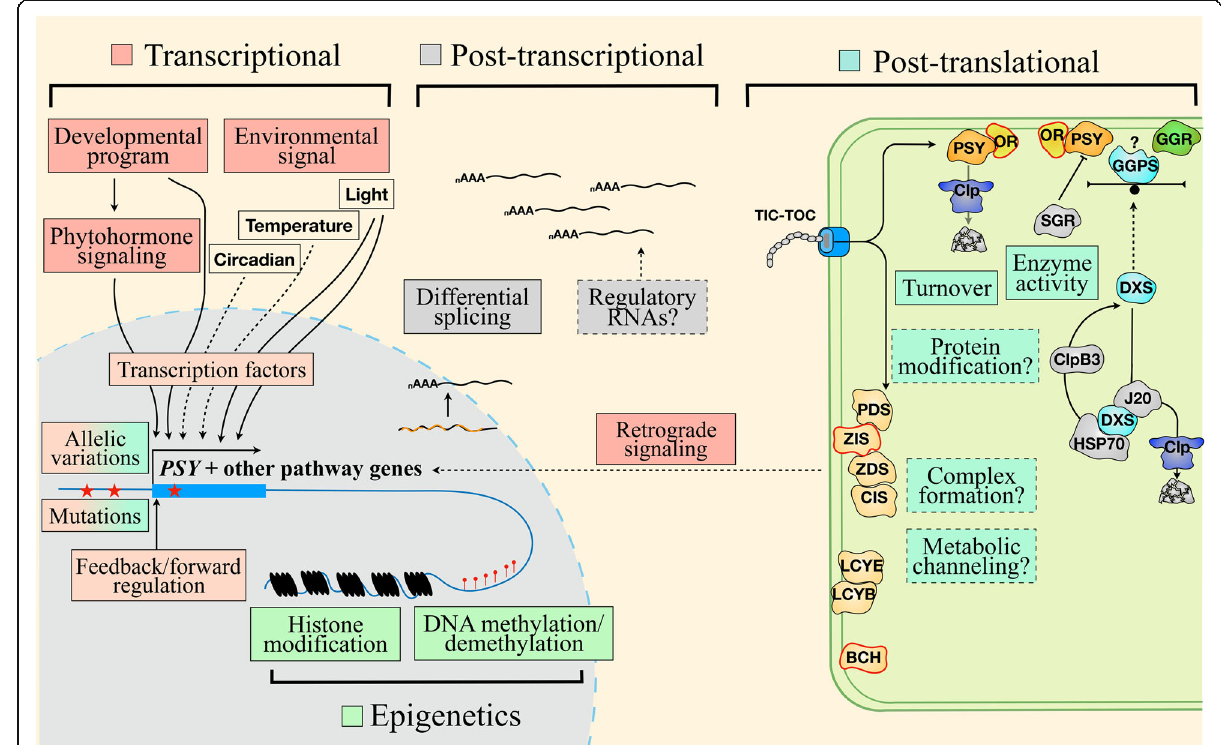
Fig. 2 Hierarchical regulation of carotenoid metabolism. Carotenoid metabolism is regulated by many signals including environmental cues, developmental program, and phytohormone signaling along with retrograde signaling. These signals converge at the level of transcription factors to regulate carotenogenic gene expression. In addition, allelic variation, mutations, and feedback and forward regulation affect the transcription of pathway genes or the activities of key enzymes. Epigenetic regulation also controls carotenogenic gene expression. Differential splicing